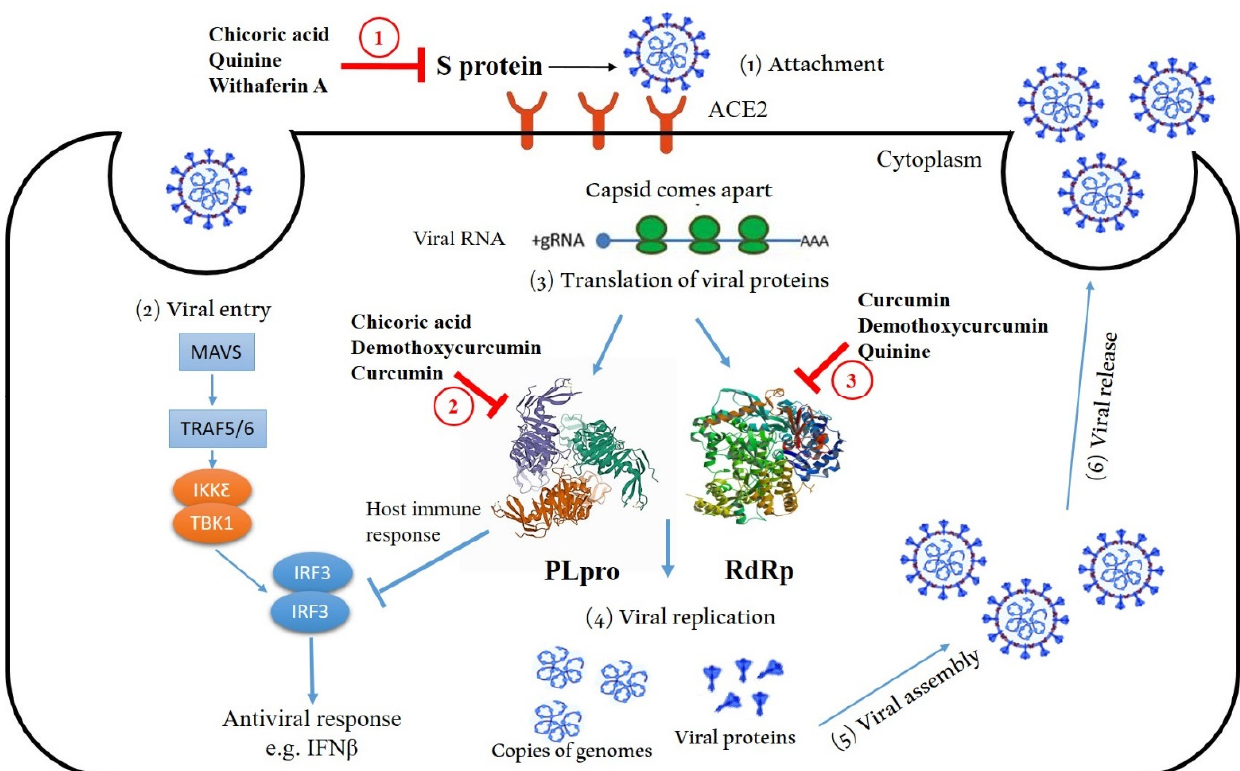
Figure 6. The proposed mechanism of SARS-CoV-2 inhibition by tested compounds.